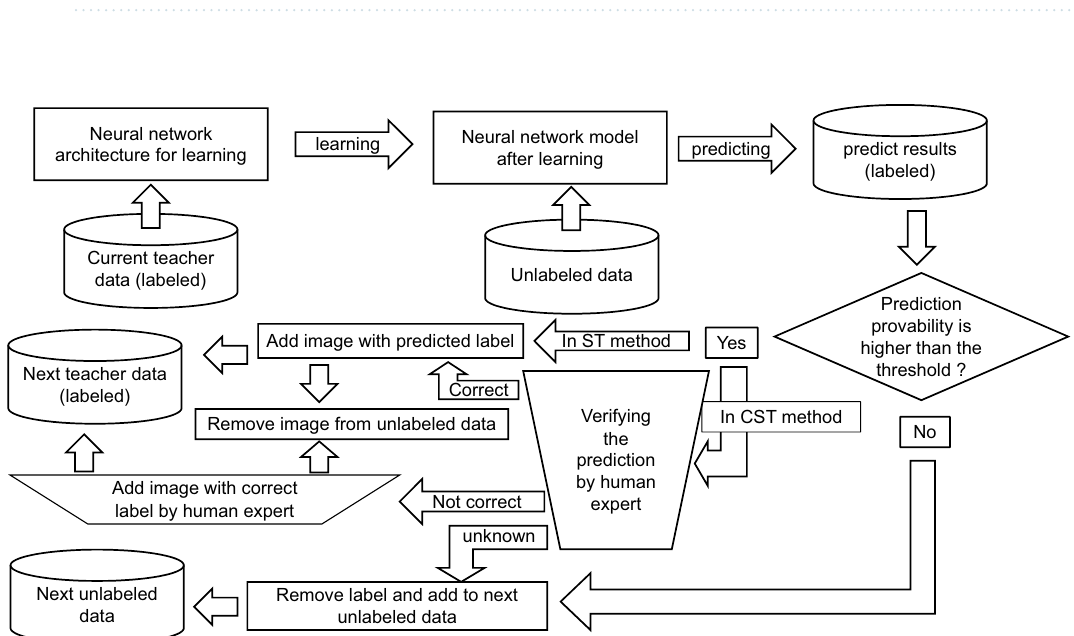
Figure 7. Semi-supervised learning process with self-training (ST) and confirmed self-training (CST) methods. The inverted trapezoidal frame shows manual processing or human judgment. The rectangular frame shows automatic processing by a hand-made program written in Python. The diamond frame shows the automatic judgment by a program written in python. The threshold provability in this study was